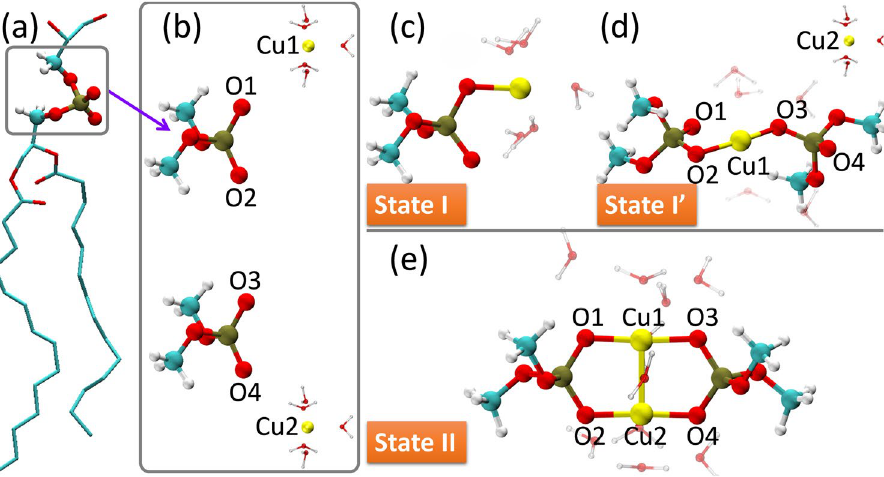
Figure 2. Ways of two hydrated Cu 2 + ions binding with two phospholipids. The cyan, brown, red, white and yellow balls represent carbon, phosphorus, oxygen, hydrogen and copper, respectively. ( a ) A phosphate group in a phospholipid (PL). ( b – d ) Hydrated Cu 2 + ions binding to phospholipids based on a simplified model, H 3 C- [PO 4 ] − -CH 3 . ( b ) Initial state. Four molecular groups (H 3 C-[PO 4 ] − -CH 3 and [Cu(H 2 O) 5 ] 2 + ) are separated by a large distance. ( c ) State I. Two Cu 2 + ions bind to two phospholipids, respectively, resulting in two [PL-Cu(aq)] + structures. ( d ) State I ′ . One Cu 2 + ion binds to two phospholipids, forming a structure [PL-Cu(aq)-PL]. ( e ) State II. Two Cu 2 + ions bind simultaneously with two phospholipids, forming a [PL- di Cu(aq)-PL] 2 + structure.